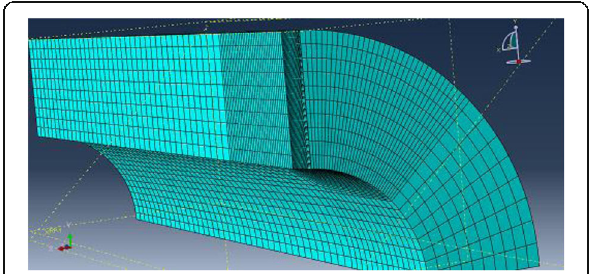
Fig. 3 Selected profile of the